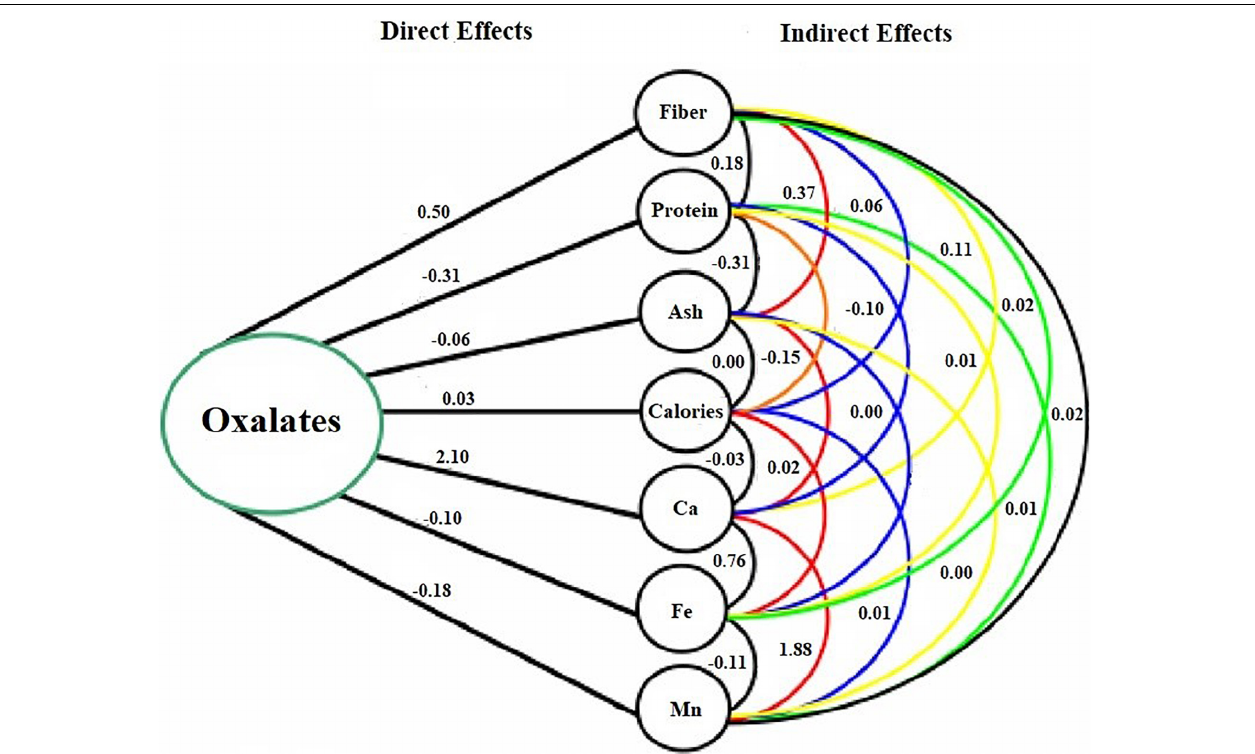
FIGURE 2 | Path diagram representing direct and indirect effects of nutrients on oxalates.